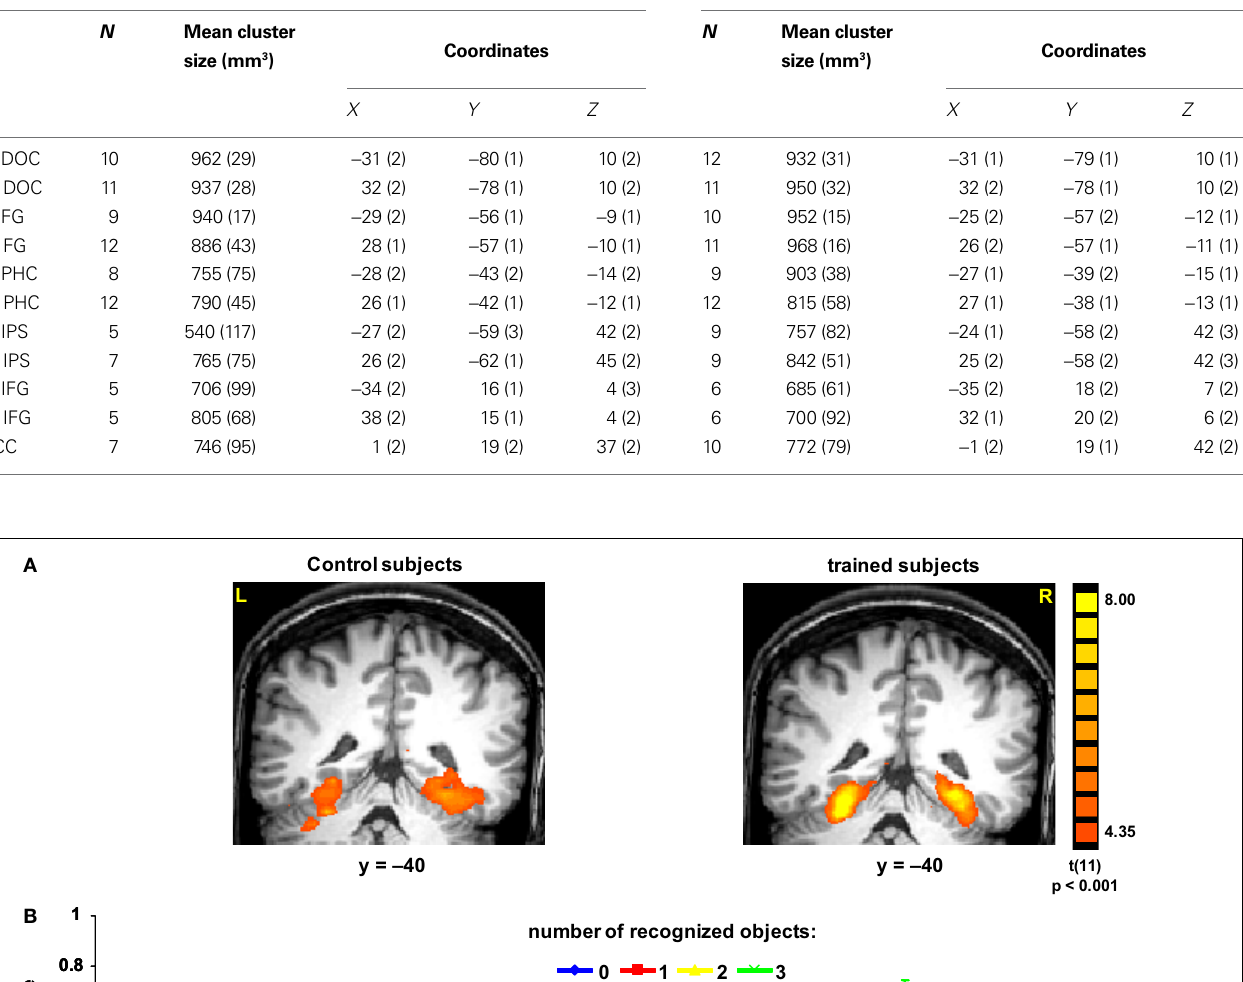
Table 1 | Regions activated during presentation of cubist paintings. N indicates number of subjects who showed activation in a region. Coordinates are in the normalized space of the Talairach and Tournoux brain atlas. Numbers in parentheses indicate standard error of the mean (SEM). Region Control group Trained group